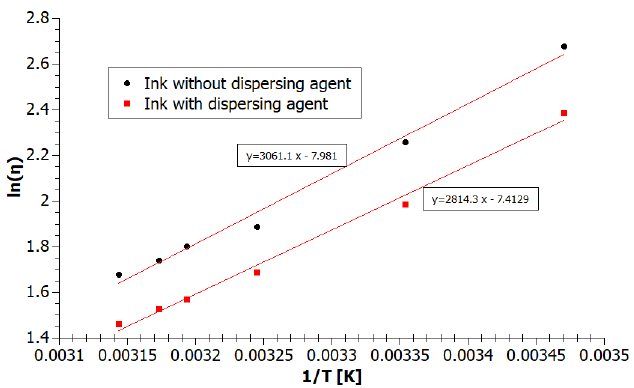
Figure 6. Diagram of viscosity as a linear function of the reciprocal of temperature.